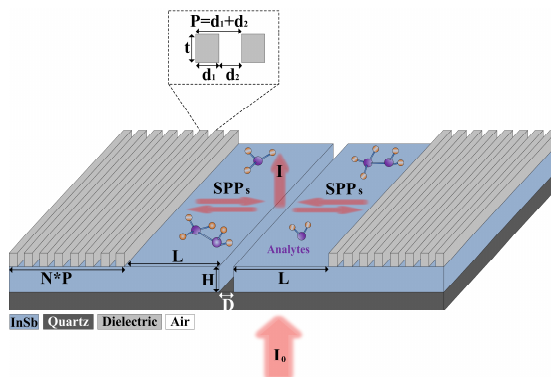
Figure 1. Three-dimensional (3D) view of proposed surface plasmon polaritons (SPPs) interferometer structure, which is composed of a microslit patterned InSb film coated on a quartz substrate. Two identical Bragg gratings are placed on both sides of microslit. Inset: Schematic view of a unit of Bragg grating.